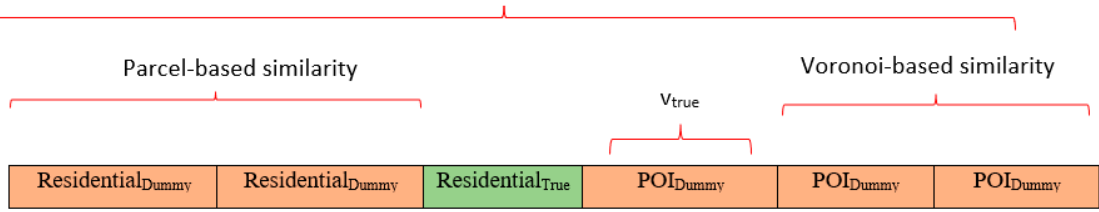
Figure 1. A three-tiered location privacy protection for a location set that contains one legitimate location and five dummy ones ( k = 6).